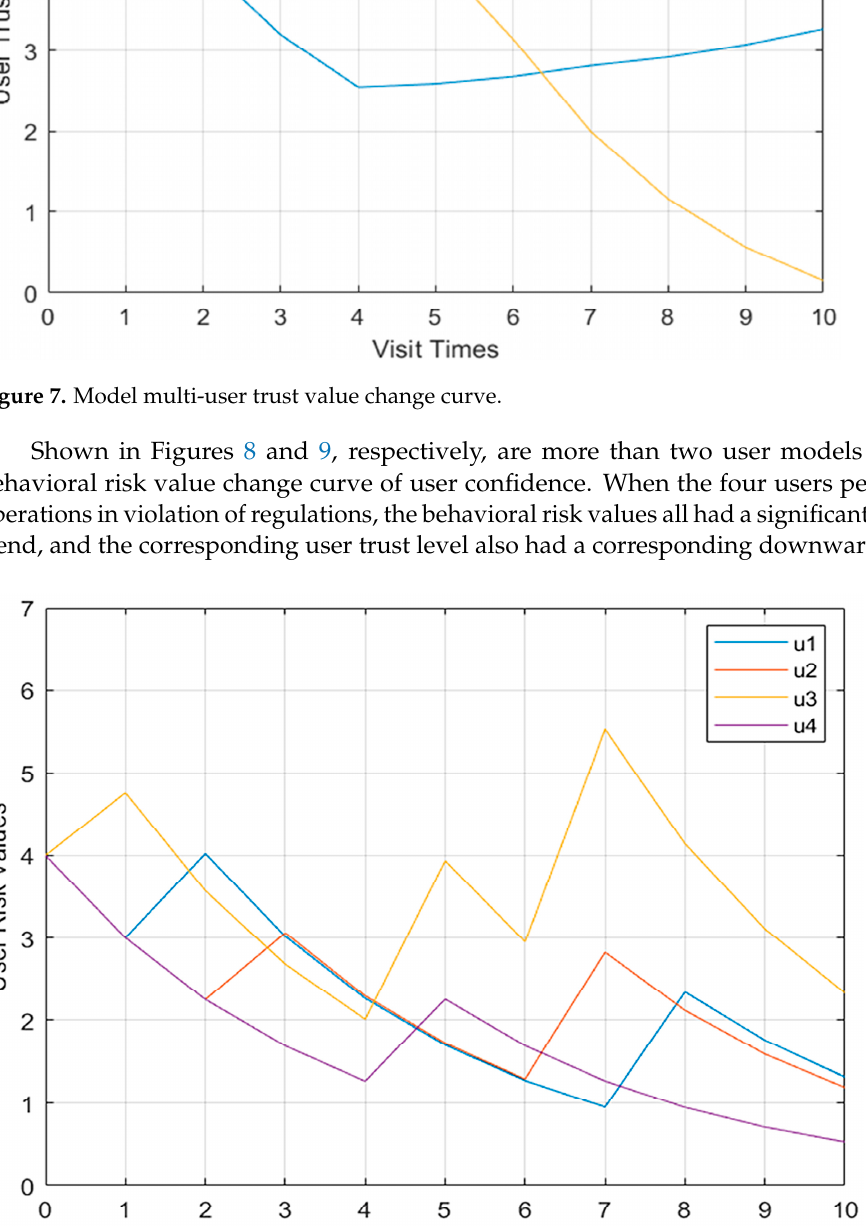
Figure 9. Multi-user trust value change curve of Model 2. According to the experimental results, the TMBRE model does not consider the im- pact of the number of threat behaviors on the trust of entities when evaluating trust. How- ever, the ABAEC model makes up for the defect. The trust value of the ABAEC model decreases when the risk value of user behavior increases. When there is only one threat behavior, ABAEC has a sharp increase in the behavior risk value when there is a second- ary threat, and the trust degree decreases, which is more in line with the actual situation. When multiple users carry out threatening behaviors, the behavior risk value of the ABAEC model has an obvious upward trend, and the corresponding user trust degree also has a corresponding downward trend, which is more in line with the basic law. The effect is better than the TMBRE model. Therefore, the ABAEC model is more reasonable and effective, and can better protect medical equipment resources. 5. Conclusions With the wide application of Internet technology in the medical field, the intelligent medical system has many network security problems. The problems such as data leakage caused by attacks will pose a serious threat to the life safety of patients. The data security of medical equipment has become one of the important factors affecting the promotion and application of intelligent medical systems. Therefore, it is necessary to strengthen the